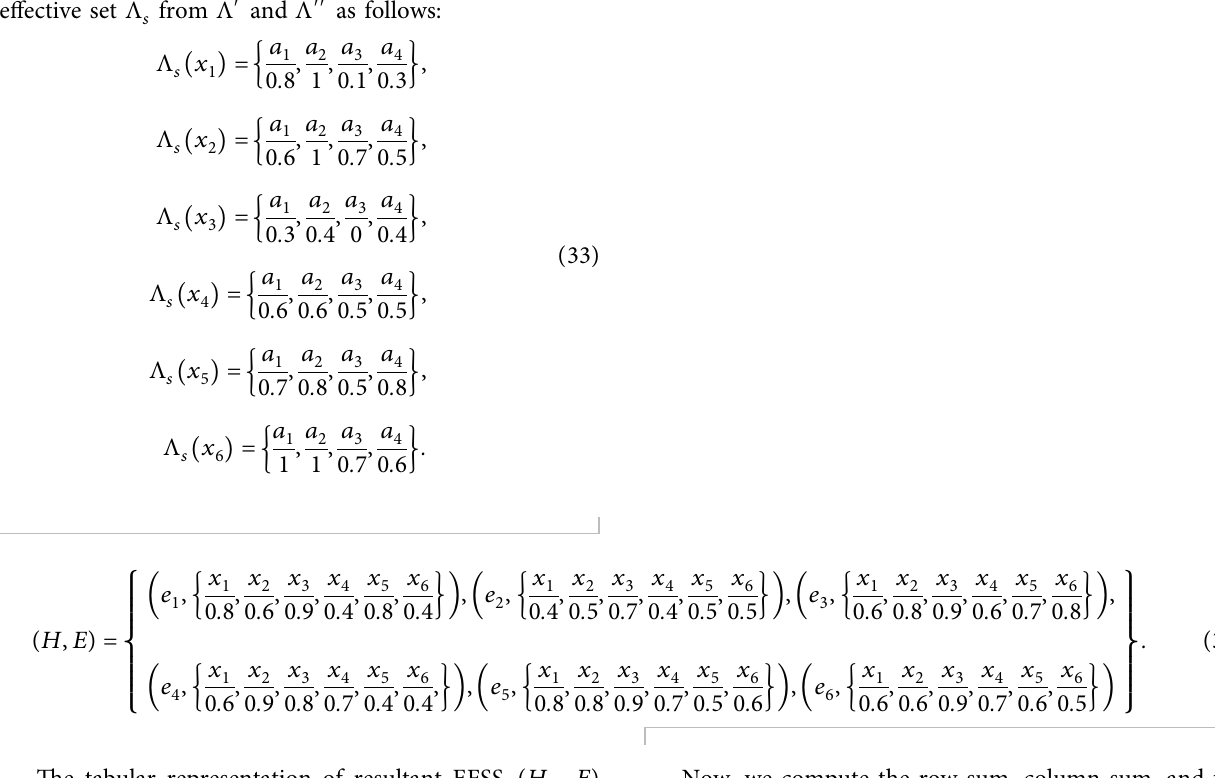
The comparison table of the above resultant effective fuzzy soft set is in Table